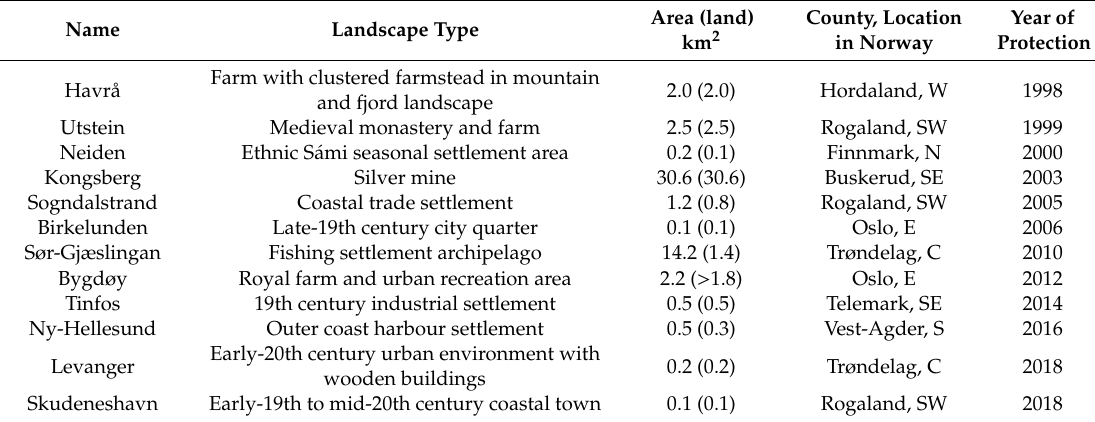
Table 1. Protected cultural heritage environments in